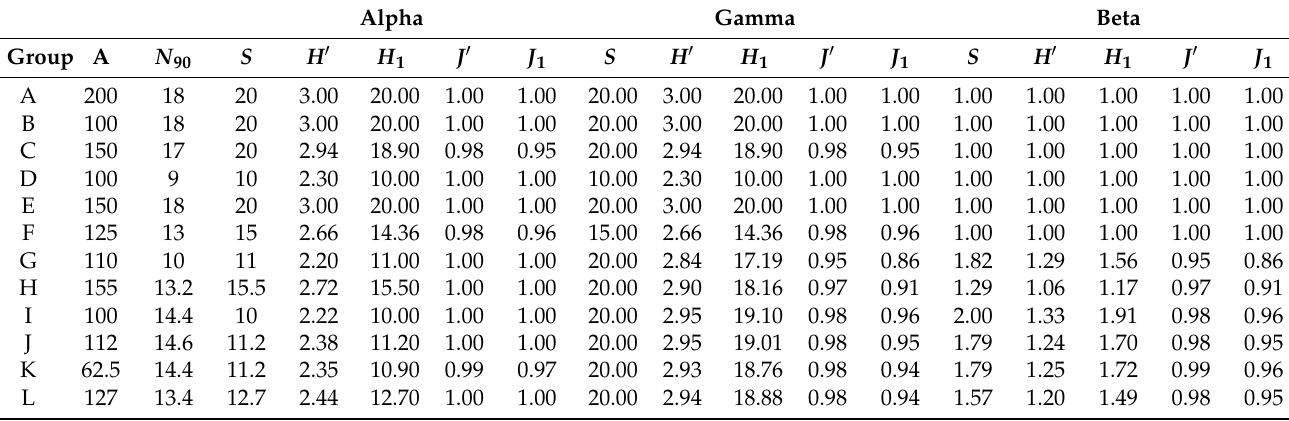
Table 1. Results of N 90 and alpha, beta and gamma versions of Species Richness ( S ), Shannon ( H (cid:48) ), Hill number of order 1 ( H 1 ) and Pielou’s evenness ( J (cid:48) ) for the non-real data set. A is the mean abundance in the group of